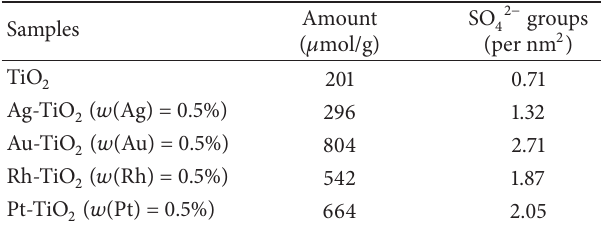
Table 2: Amount of SO 42− groups on prepared catalysts.